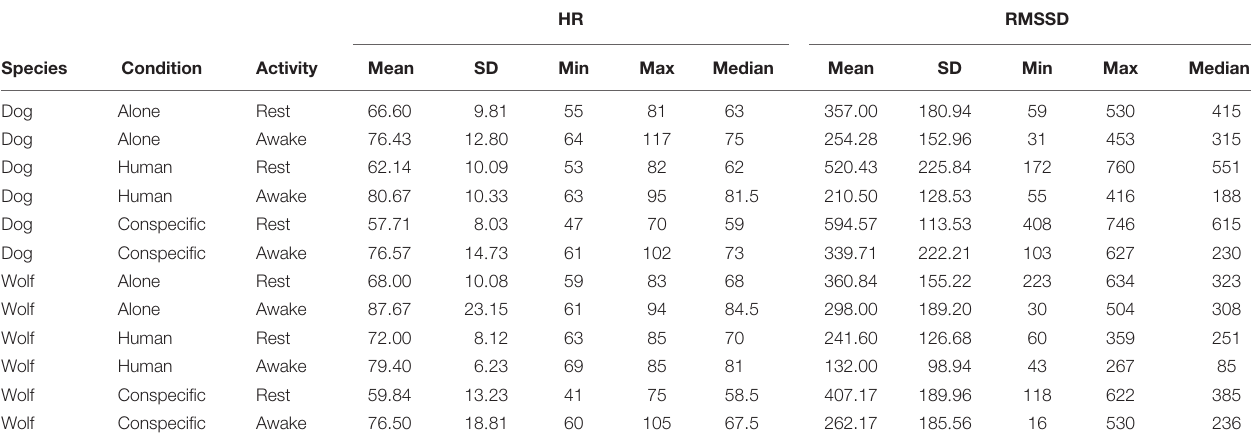
TABLE 3 | Descriptive statistics for the mean HR and RMSSD values.